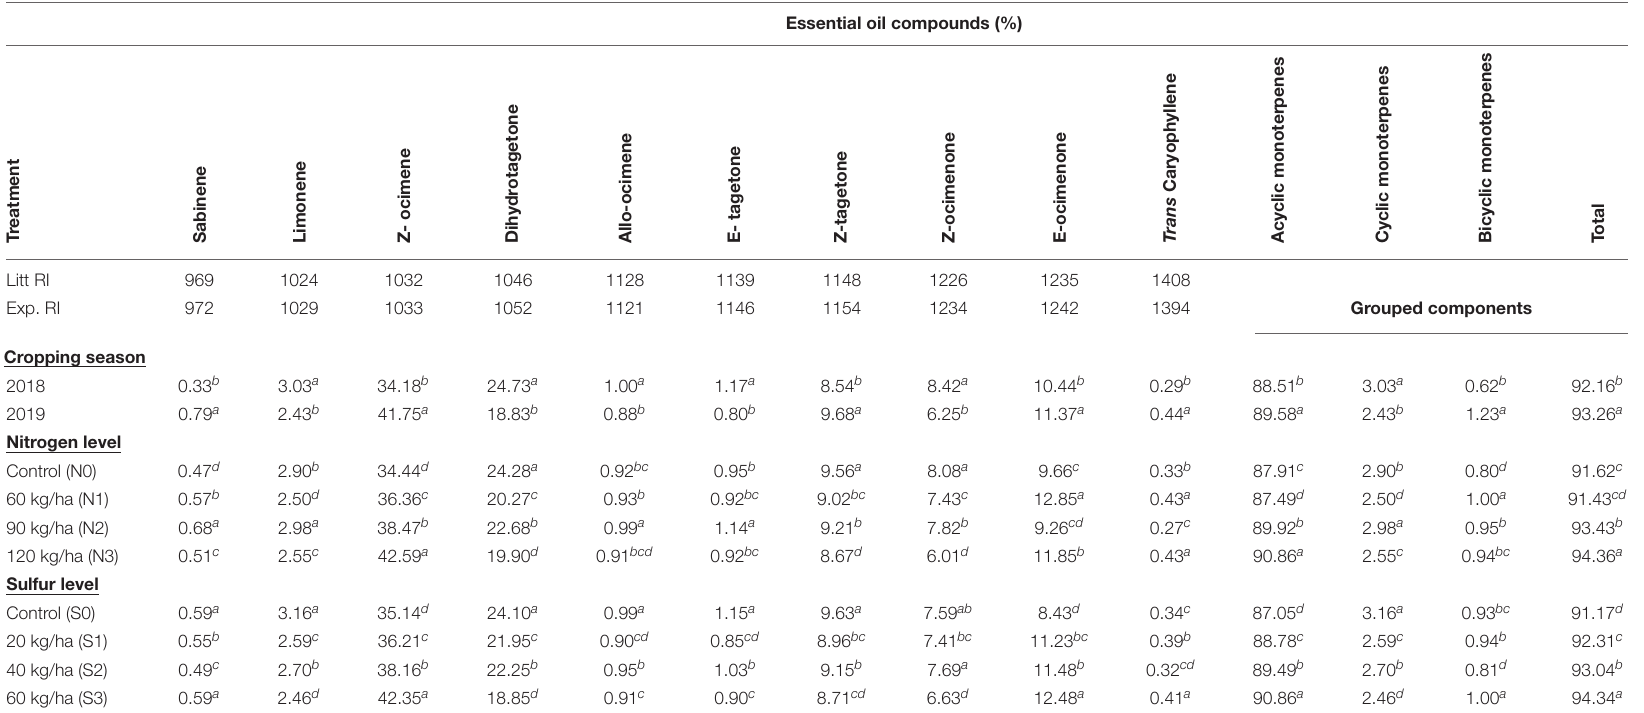
TABLE 6 | Effect of year and fertilization levels on essential oil composition of T. minuta